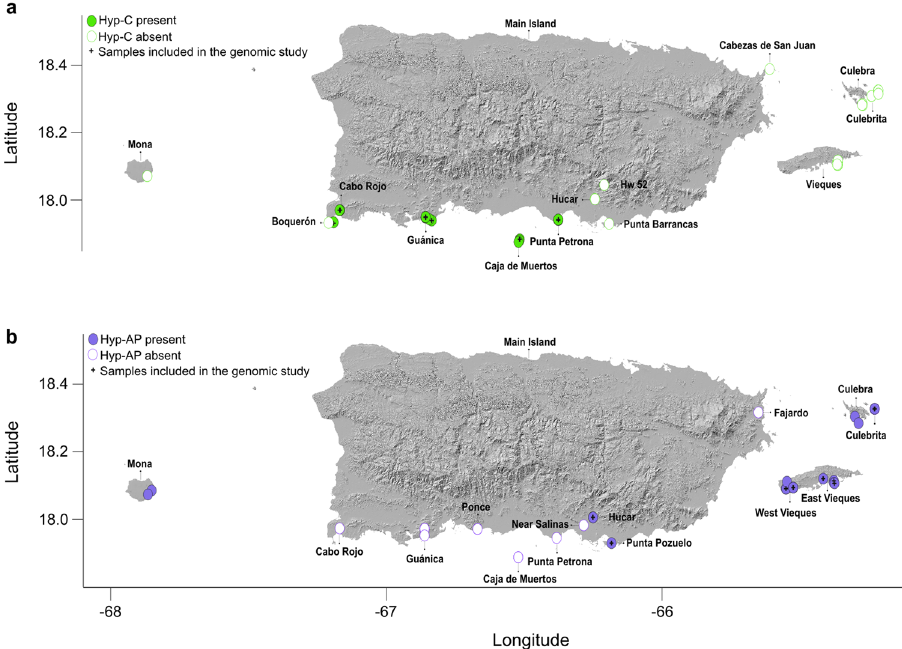
Figure 2. Geographic location where Hypogeococcus spp. mealybugs populations were sampled. Sites on Puerto Rican main island and its nearby outer islands (Vieques, Culebra, Culebrita, Caja de Muertos, and Mona) surveyed for presence of both Hypogeococcus species Hyp-C ( a ) and Hyp-AP ( b ).